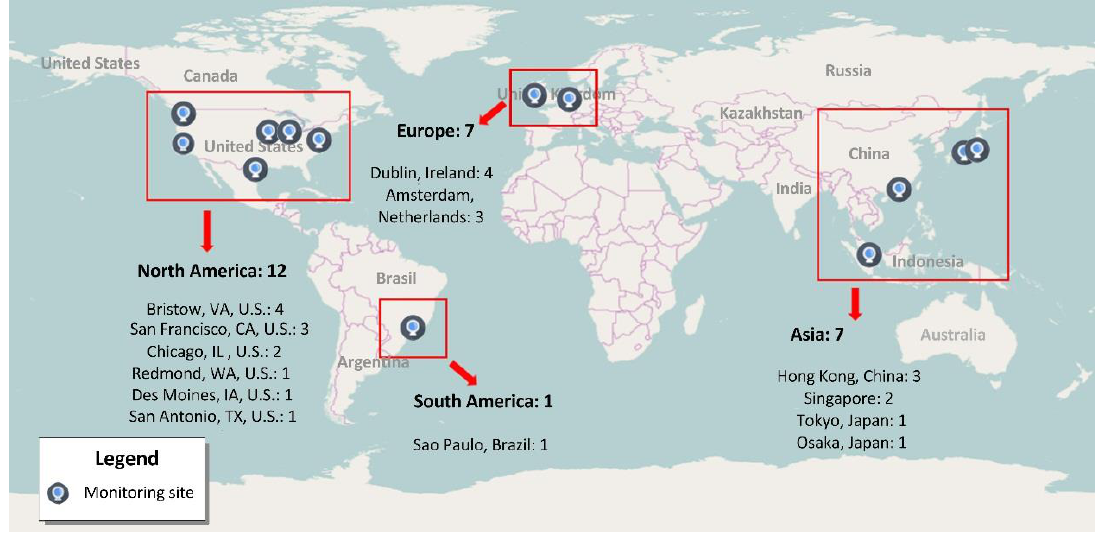
Figure 4. The geo-locations of monitoring sites.